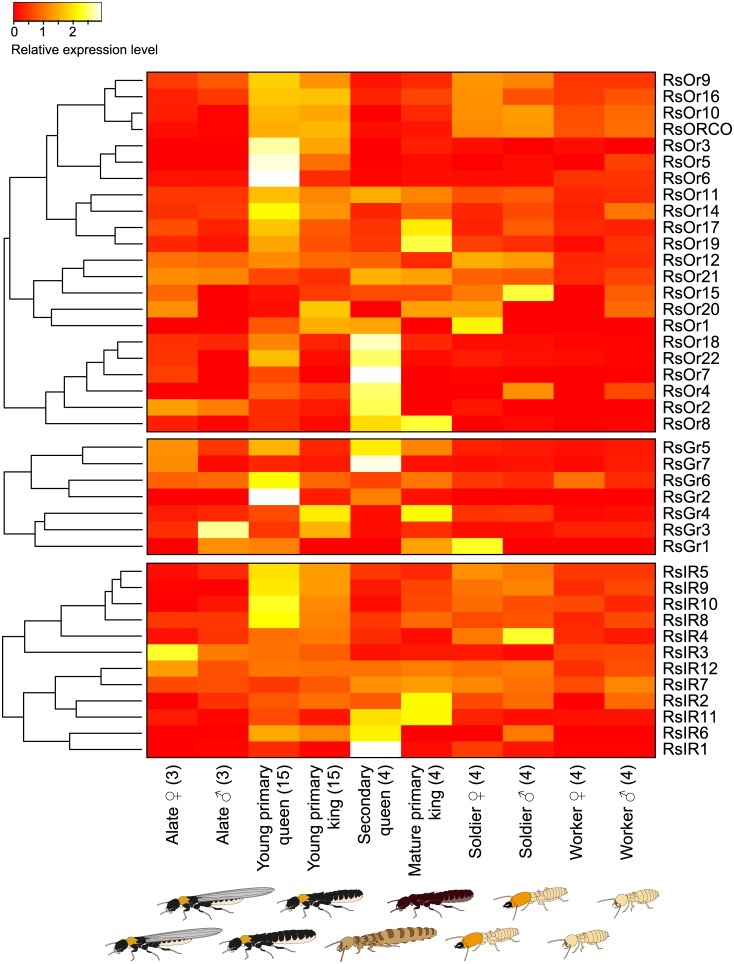
Differential expression of chemoreceptors among castes.The heatmaps exhibit the differential expression of 22 OR, 7 GR, and 12 IR genes among termite castes. Relative expression level indicates the mean normalized Count per Million (CPM), ranging from red (scaled expression of 0) to white (scaled expression of 2.5). The tree at the left corresponds to hierarchical clustering of cluster-averaged expression. Numbers in parenthesis after caste names refer to the numbers of biological replication. Ten individuals were pooled for each sex of worker and soldier to obtain sufficient amount of RNA, while single individuals were used for RNA extraction of the other castes.